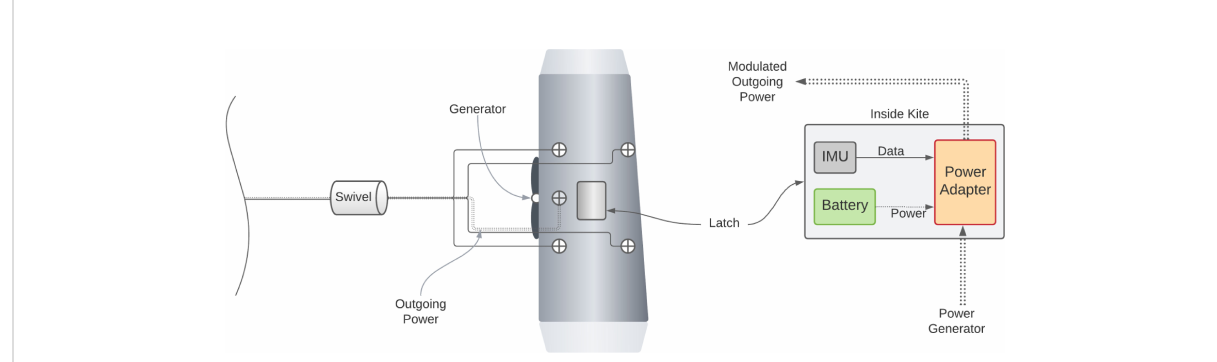
FIGURE 4 Schematic drawing of the second prototype TUSK. From left to right: To decouple the twisting a power transmitting swivel is placed in between the TUSK and the anchoring point. The wing is designed in a asymmetrical shape and is equipped with a generator on the backside. The computational equipment is stored inside the wing and further illustrated in the cut